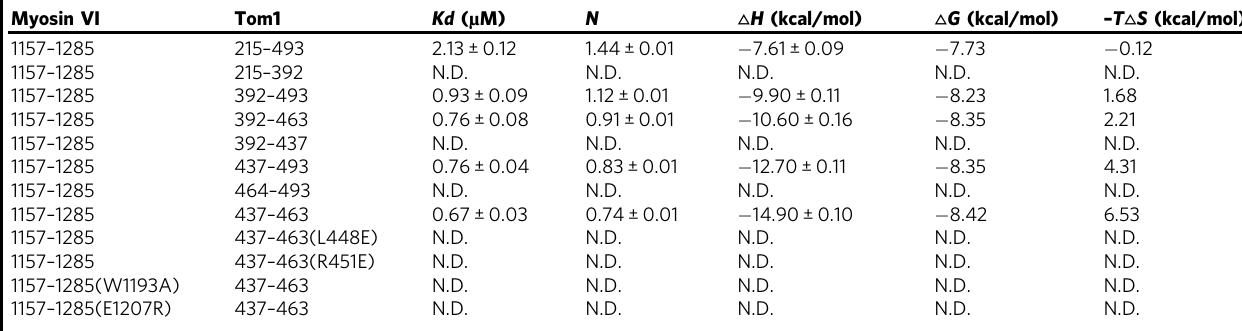
Table 1 Statistics of ITC results between different variants of Myosin VI and Tom1 Myosin VI